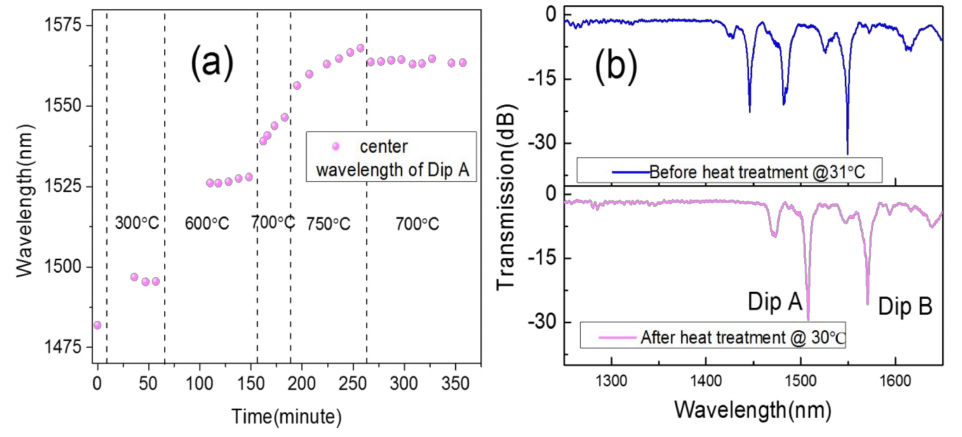
Figure 3. Post-processing of the LPFG. ( a ) The center wavelength shifts with time and increasing temperature. ( b ) Comparison of the spectrum of the LPFG before and after heat